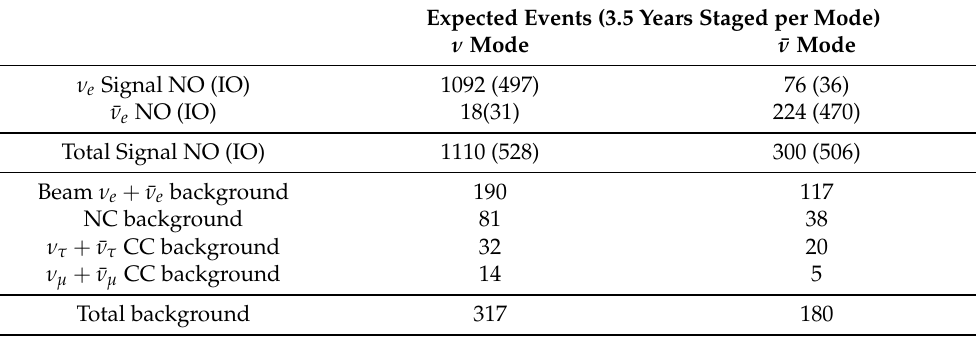
Table 1. ν e / ¯ ν e appearance rates: Integrated rate of selected ν e CC-like events between 0.5 and 8.0 GeV assuming 3.5-year (staged) exposures in the neutrino-beam and antineutrino-beam modes. The signal rates are shown for both normal mass ordering (NO) and inverted mass ordering (IO), and all the background rates assume normal mass ordering. All the rates assume δ CP = 0, and NuFIT 4.0 [28, 29] values for other parameters. (Reproduced from the Far Detector Technical Design Report).